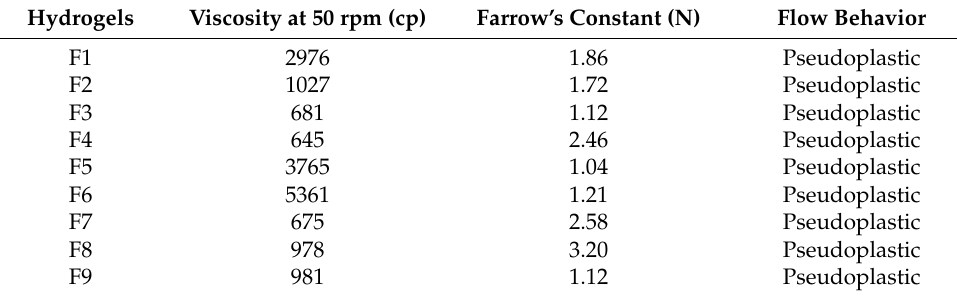
Table 3. Rheological properties of BH hydrogels.